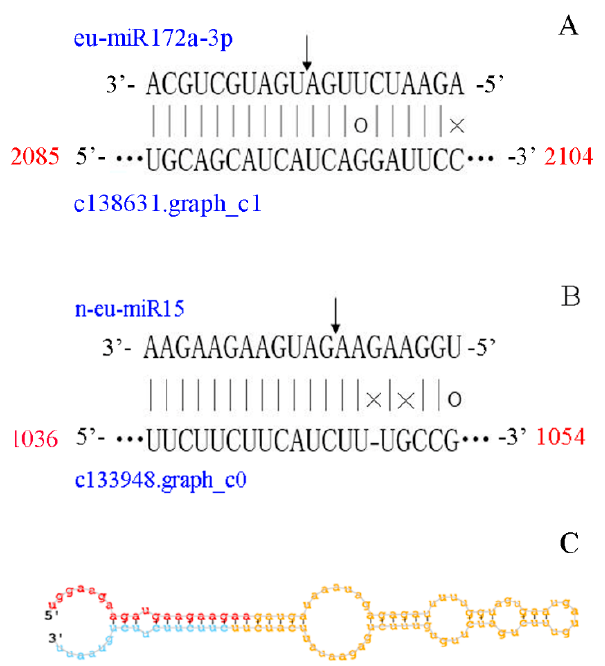
Figure 5. Confirmation of the cleavage sites of eu-miR172a-3p and n-eu-miR15 with their targets by RLM-5 (cid:48) RACE; ( A ) eu-miR172a-3p / c138631.graph_c1; ( B ) n-eu-miR15 / c133948.graph_c0; and ( C ) stem-loop structure of n-eu-miR15. Watson-Crick pairing (vertical dashes), G:U wobble pairing (circles), and mismatched bases (crosses) are indicated. The vertical arrows indicate the cleavage sites identified by RLM-5 (cid:48) RACE. The red portion of the stem-loop structure is the mature sequence of n-eu-miR15.